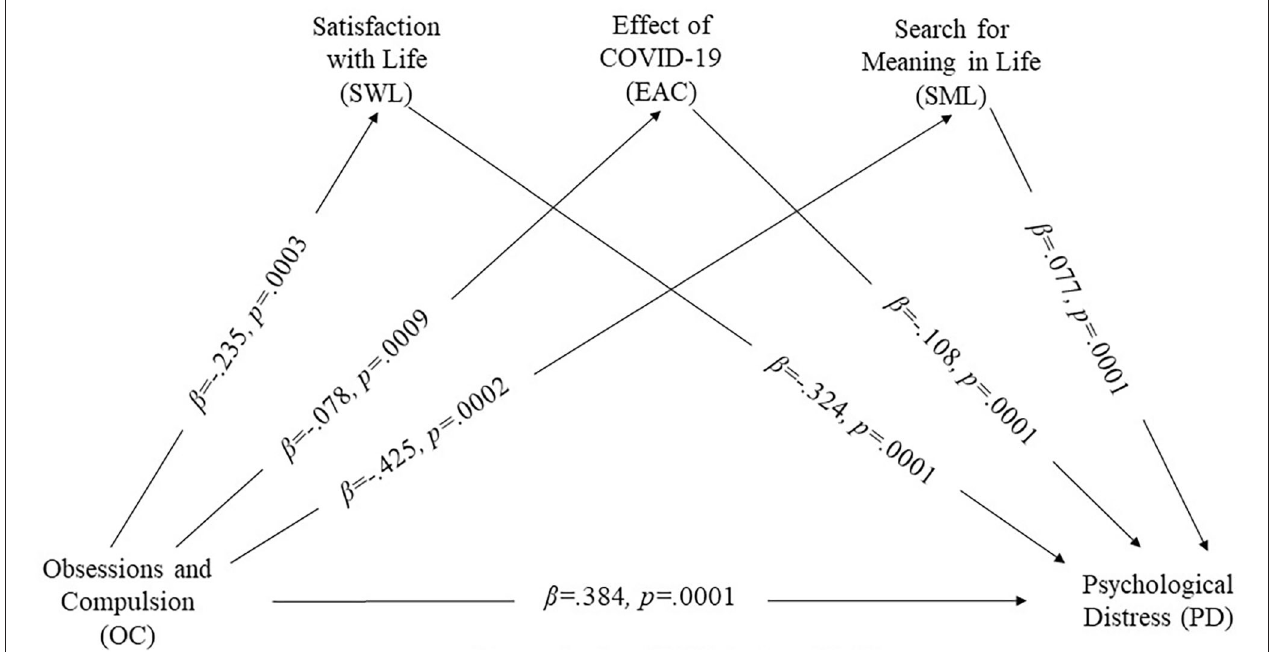
FIGURE 1 | Parallel mediation